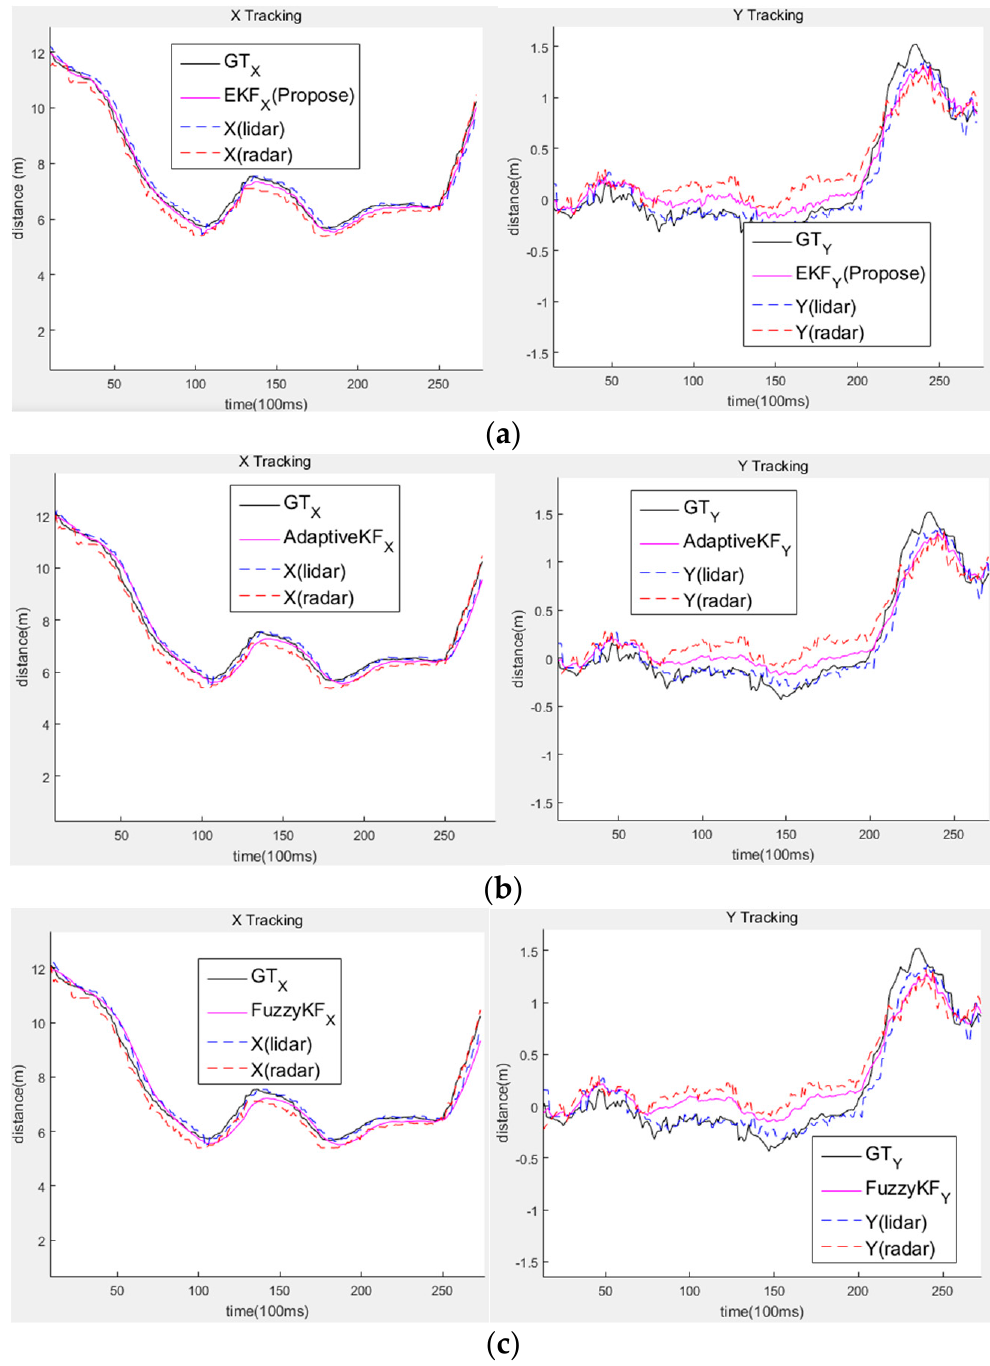
Figure 15. Comparison experiment result of other sensor fusion methods: ( a ) proposed method; ( b ) adaptive measure noise and Kalman filter; ( c ) fuzzy method and Kalman filter.